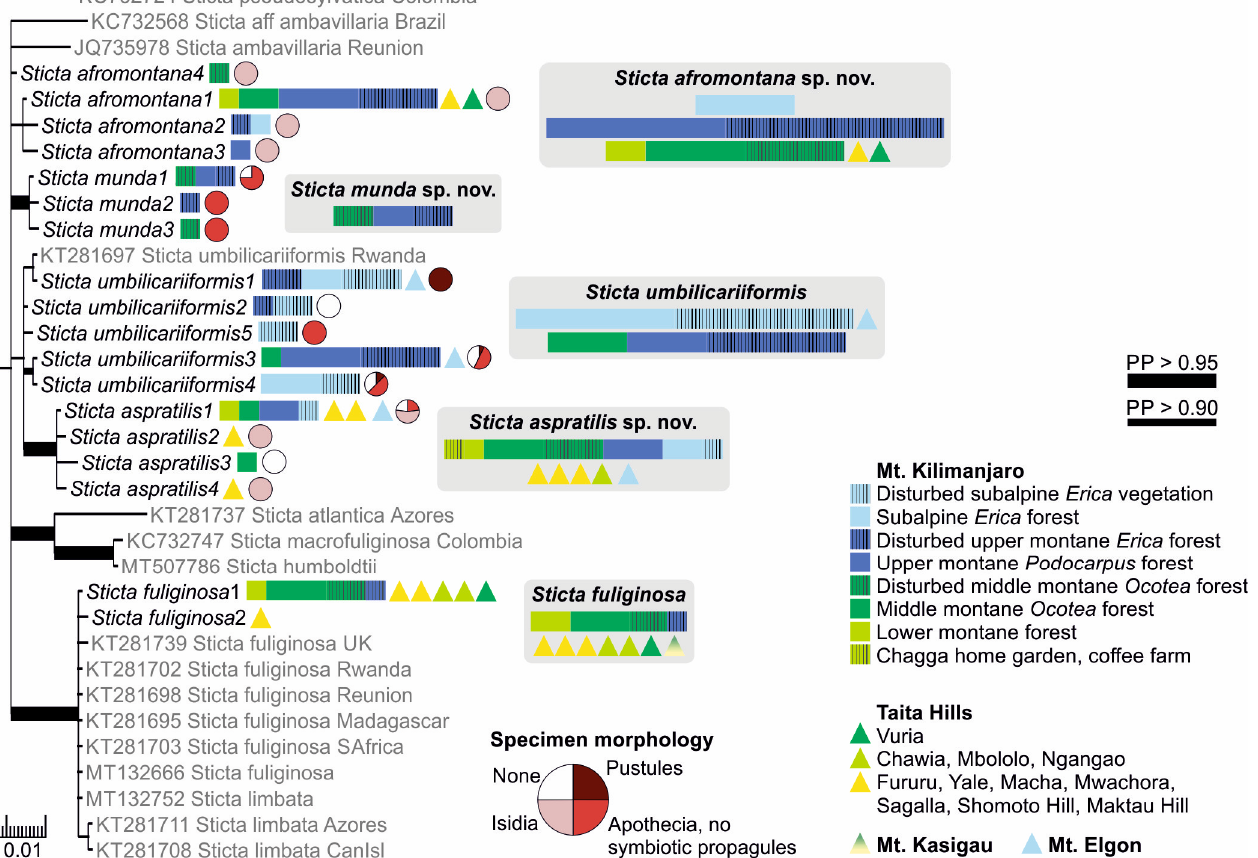
Figure 2. Phylogeny of the Sticta umbilicariiformis—fuliginosa group based on the nuITS region. The colored polygons (rectangle or triangle) in the tree show the distribution of the ITS variants in the studied regions and ecosystem types: On Mt. Kilimanjaro, the different habitats are indicated by color and grid; the width of the rectangle indicate the number of sample plots in which the taxon was present in each ecosystem type (square = 1). In the Taita Hills, each triangle indicates presence in one forest fragment and on Mt. Kasigau in one sampling transect. The grey boxes show the total abundance and distribution of the species, also including the data from unsequenced specimens. The proportions of different structures (pustules, isidia, or just apothecia) among the specimens with specific ITS variants are indicated with pie charts for the new species and S. umbilicariiformis . Stronger support (PP > 0.9) for a clade is indicated with a thicker branch. The scale refers to nucleotide substitutions per site.